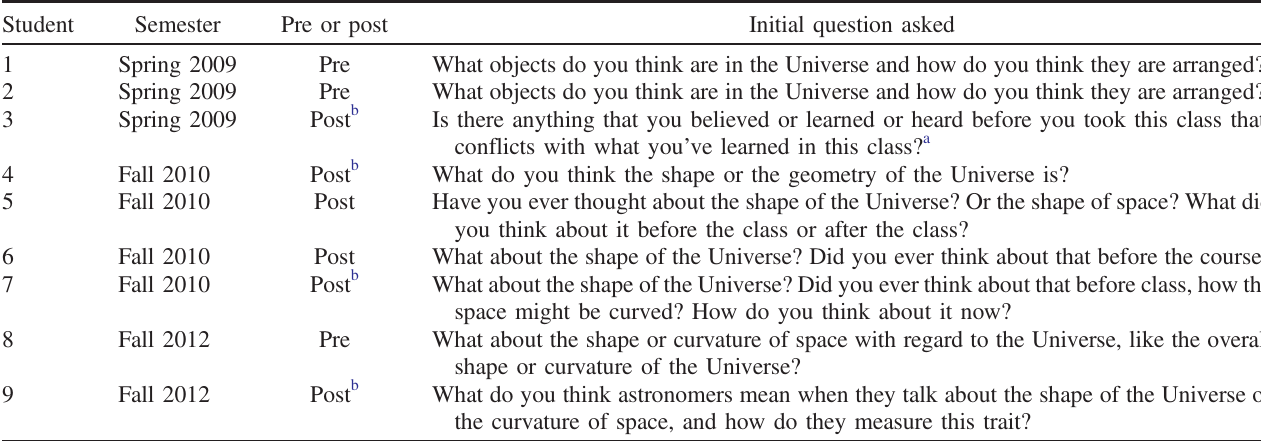
TABLE IV. Interviews in which students discussed the shape or curvature of the Universe ( N ¼ 9 ). In the first three interviews students spontaneously discussed the topic, whereas in the last six students were asked directly to address